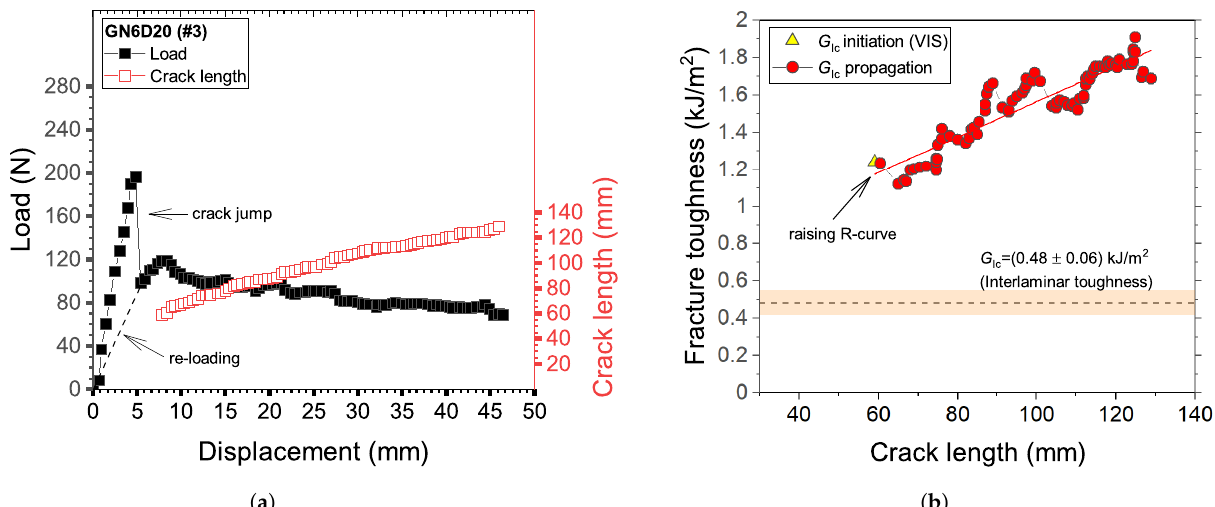
Figure 10. Typical results of DCB samples GN6D20 (sample #3). ( a ) Load-displacement and crack length displacement curves; ( b )